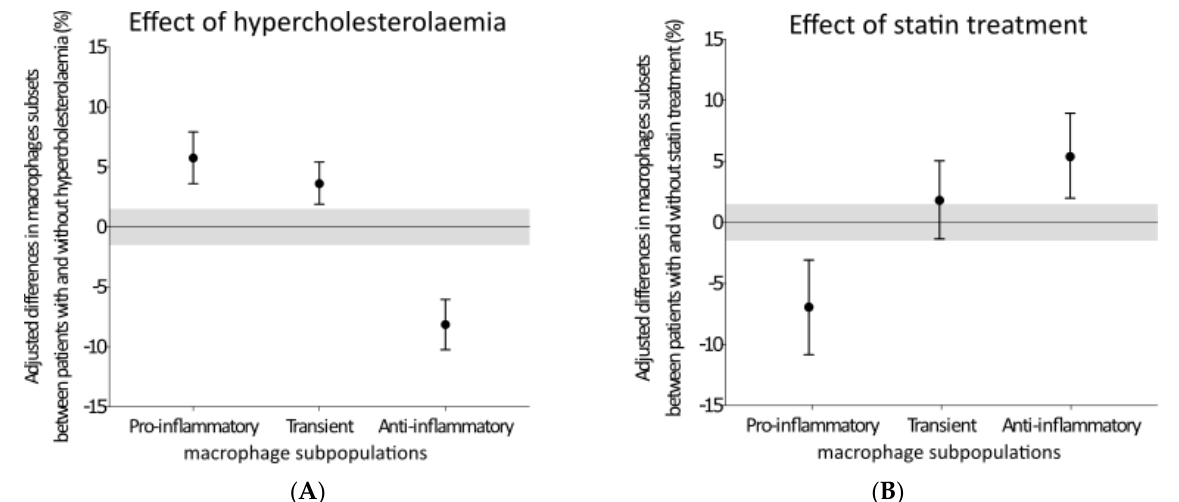
Figure 3. Effects of hypercholesterolemia ( A ) and statin therapy ( B ) in the 118 living kidney donors (LKDs) included in the Bayesian analysis. The data are expressed as the difference in the relative numbers of pro-inflammatory, transient, and anti-inflammatory phenotypes in VAT. The results are shown as the mean ± 95% confidential interval pro-inflammatory (CD14+CD16+CD36high), transient (CD14+CD16+CD36low), and anti-inflammatory (CD14+CD16-CD36low) macrophage subpopulations. The clinically irrelevant ±1.5% delta margins of the differences are shown as grey areas. The differences were obtained from multivariate linear normal regressions with Bayesian estimations using the Metropolis-Hastings algorithm.